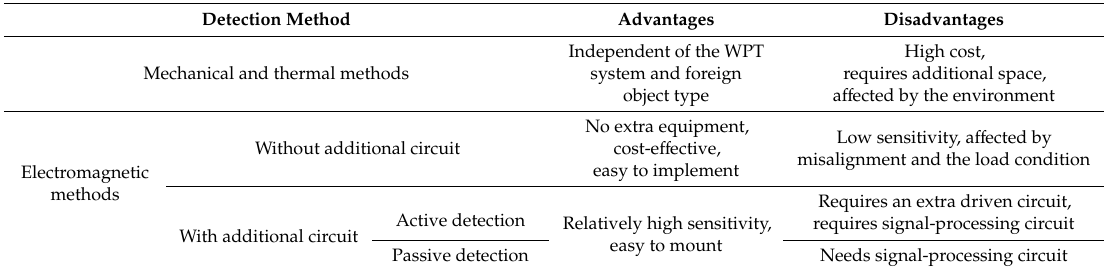
Table 3. Characteristics of the major FOD methods.